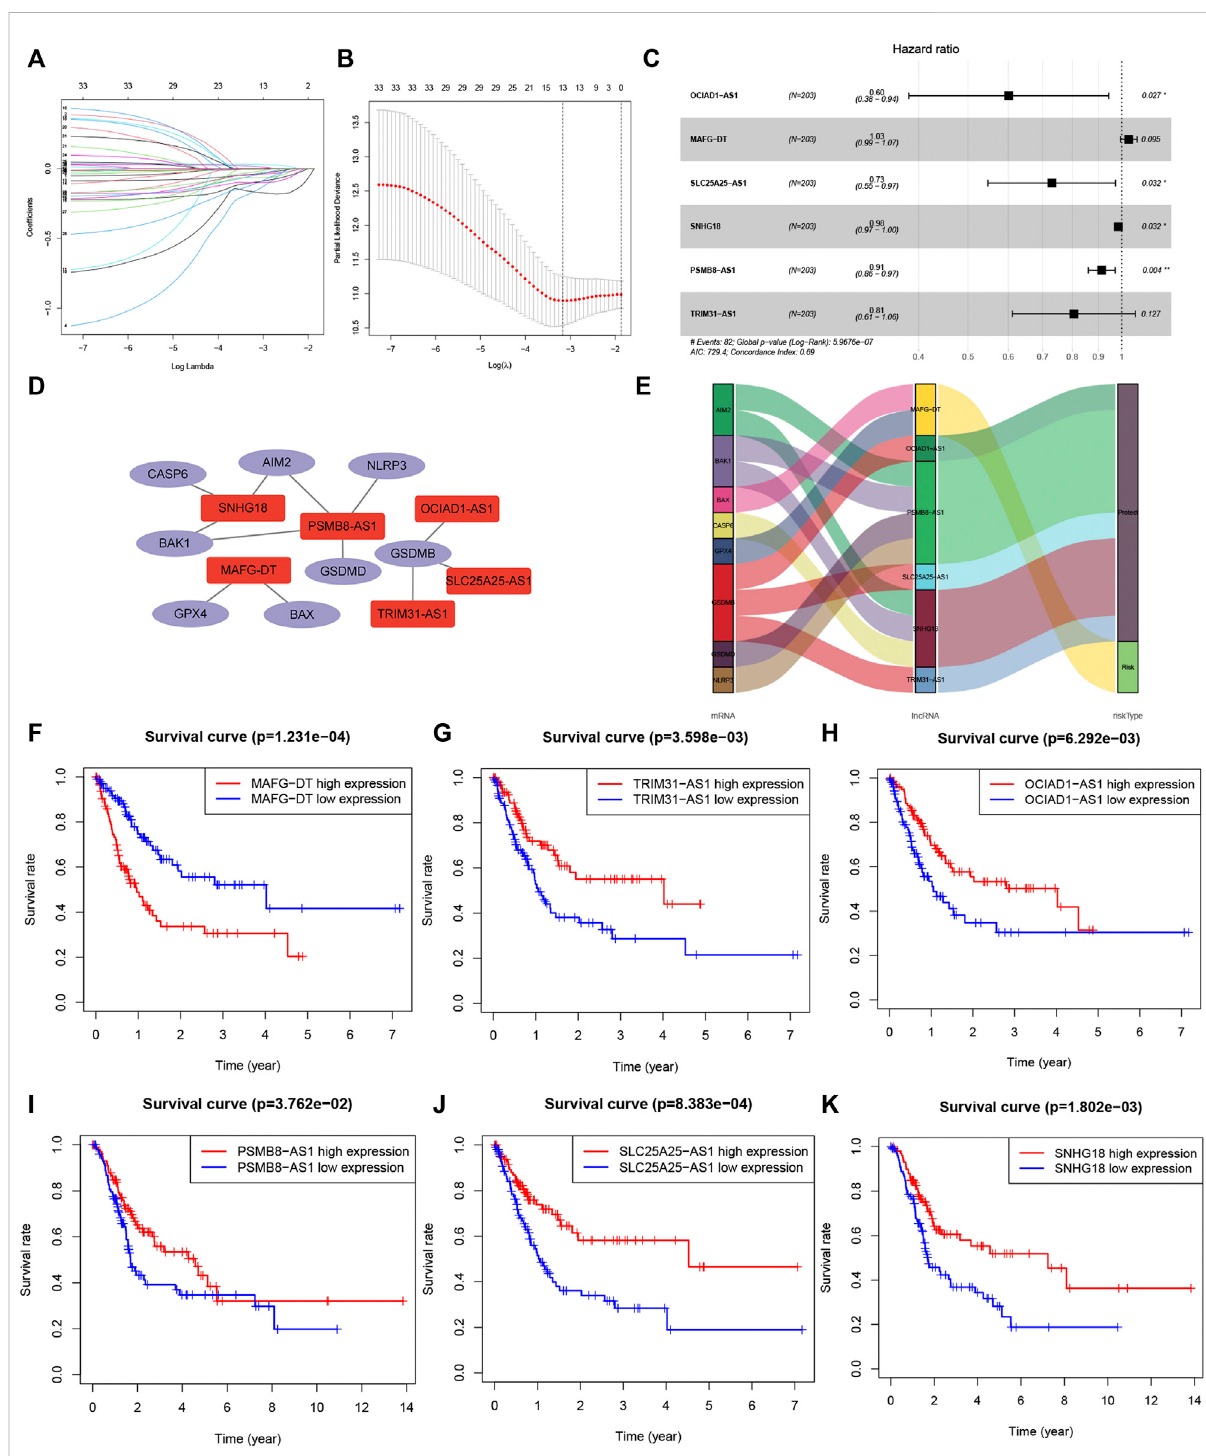
FIGURE 4 Co-expression network construction. (A,B) : LASSO Cox algorithm to establish a prognosis model; 13 PRLs were good candidates for constructingtheprognosticmodel; (C) :6lncRNAs wereselected. (D) :The co-expression structure between PRLs andgenes. (E) :Sankey diagramof the co-expression network. (F – K) : Kaplan – Meier survival analyzed the overall survival of 6 lncRNAs, OCIAD1-AS1, MAFG-DT, SLC25A25-AS1, SNHG18, PSMB8-AS1 and TRIM31-AS1. PRL, pyroptosis-related